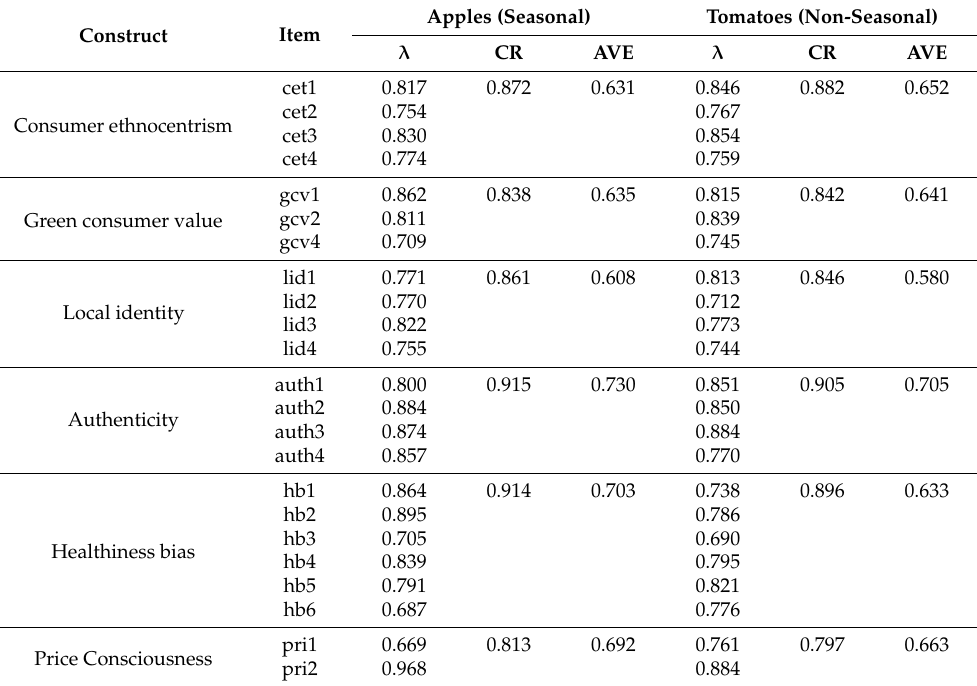
Table 5. Measurement parameters, construct reliability, and AVE